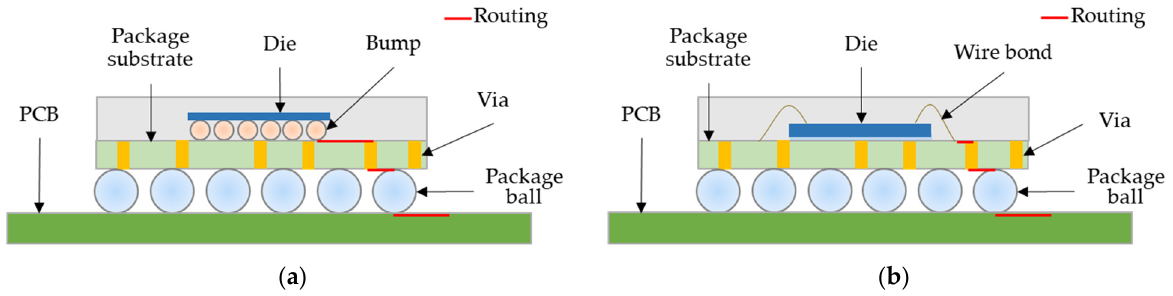
Figure 1. IC Package connections with substrate [19]. ( a ) Flip chip; ( b ) wire bonding.